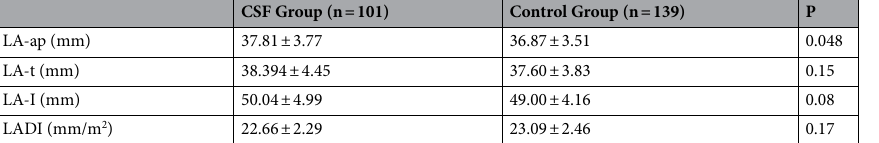
Table 5. Comparison of LA structure of CSF group and control group. Values shown are means ± SD or percentages. LA-ap anterior–posterior diameter of left atrium, LA-t transverse diameter of Ieft atrium, LA-I long diameter of left atrium, LADI left atrial diameter index.